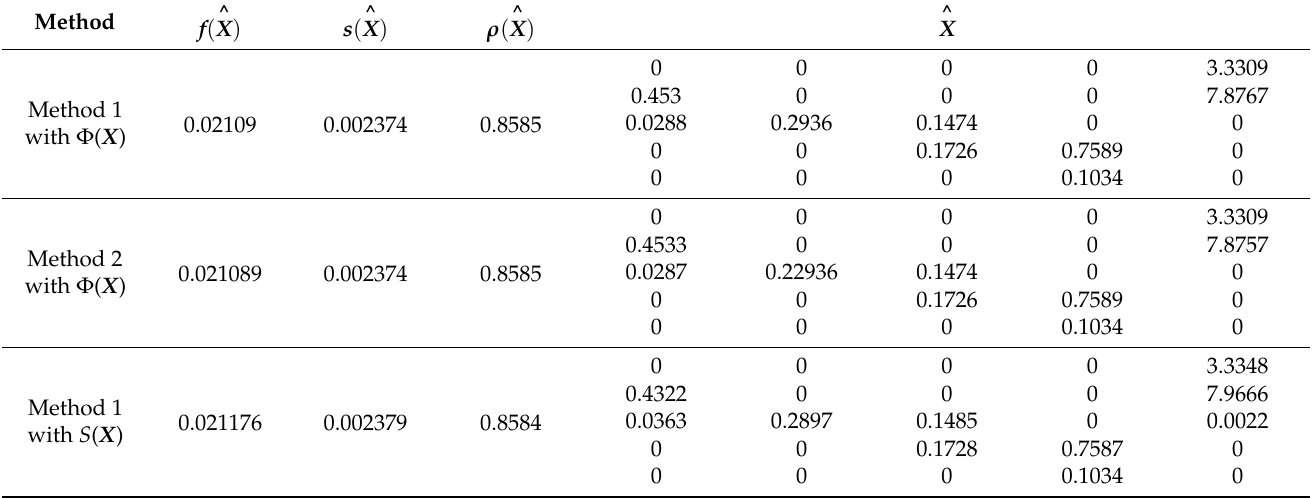
Table 4. Results for Example 1